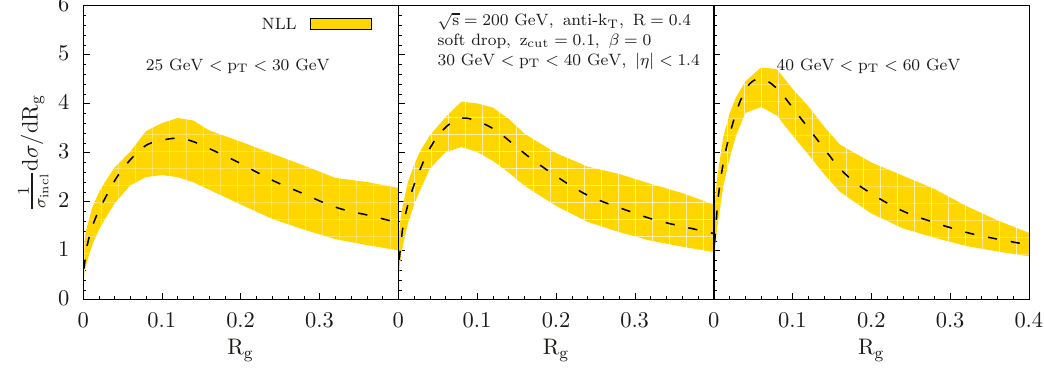
Figure 8 . The normalized soft drop groomed jet radius R g at NLL in proton-proton collisions for STAR kinematics at p s = 200 GeV. The jet kinematics and soft drop parameters are indicated in the